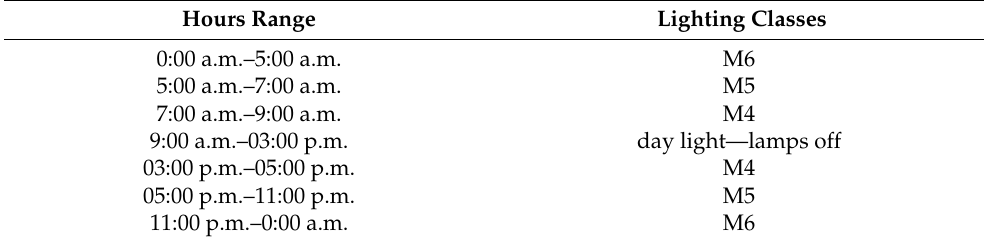
Table 4. Possible road lighting classes depending on time of day.